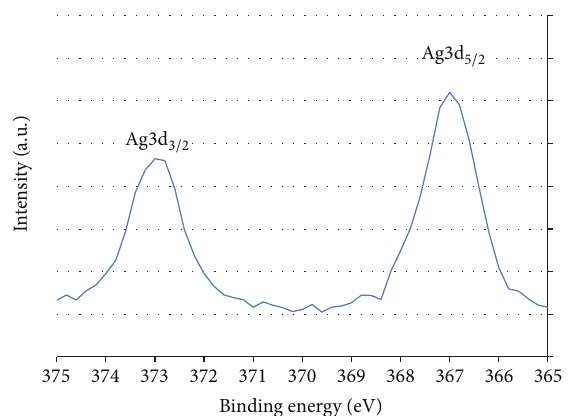
Figure 4: X-ray photoelectron spectra (XPS) of the as-synthesized Ag-TiO 2 /Fe 3 O 4 in the Ag3d region.